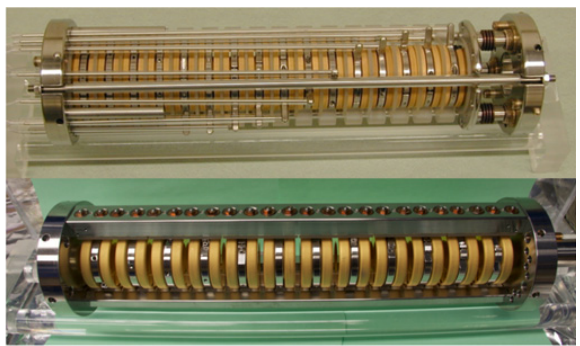
Figure 2. Photographs of electrode stacks for the mark II (top) and mark III (bottom)